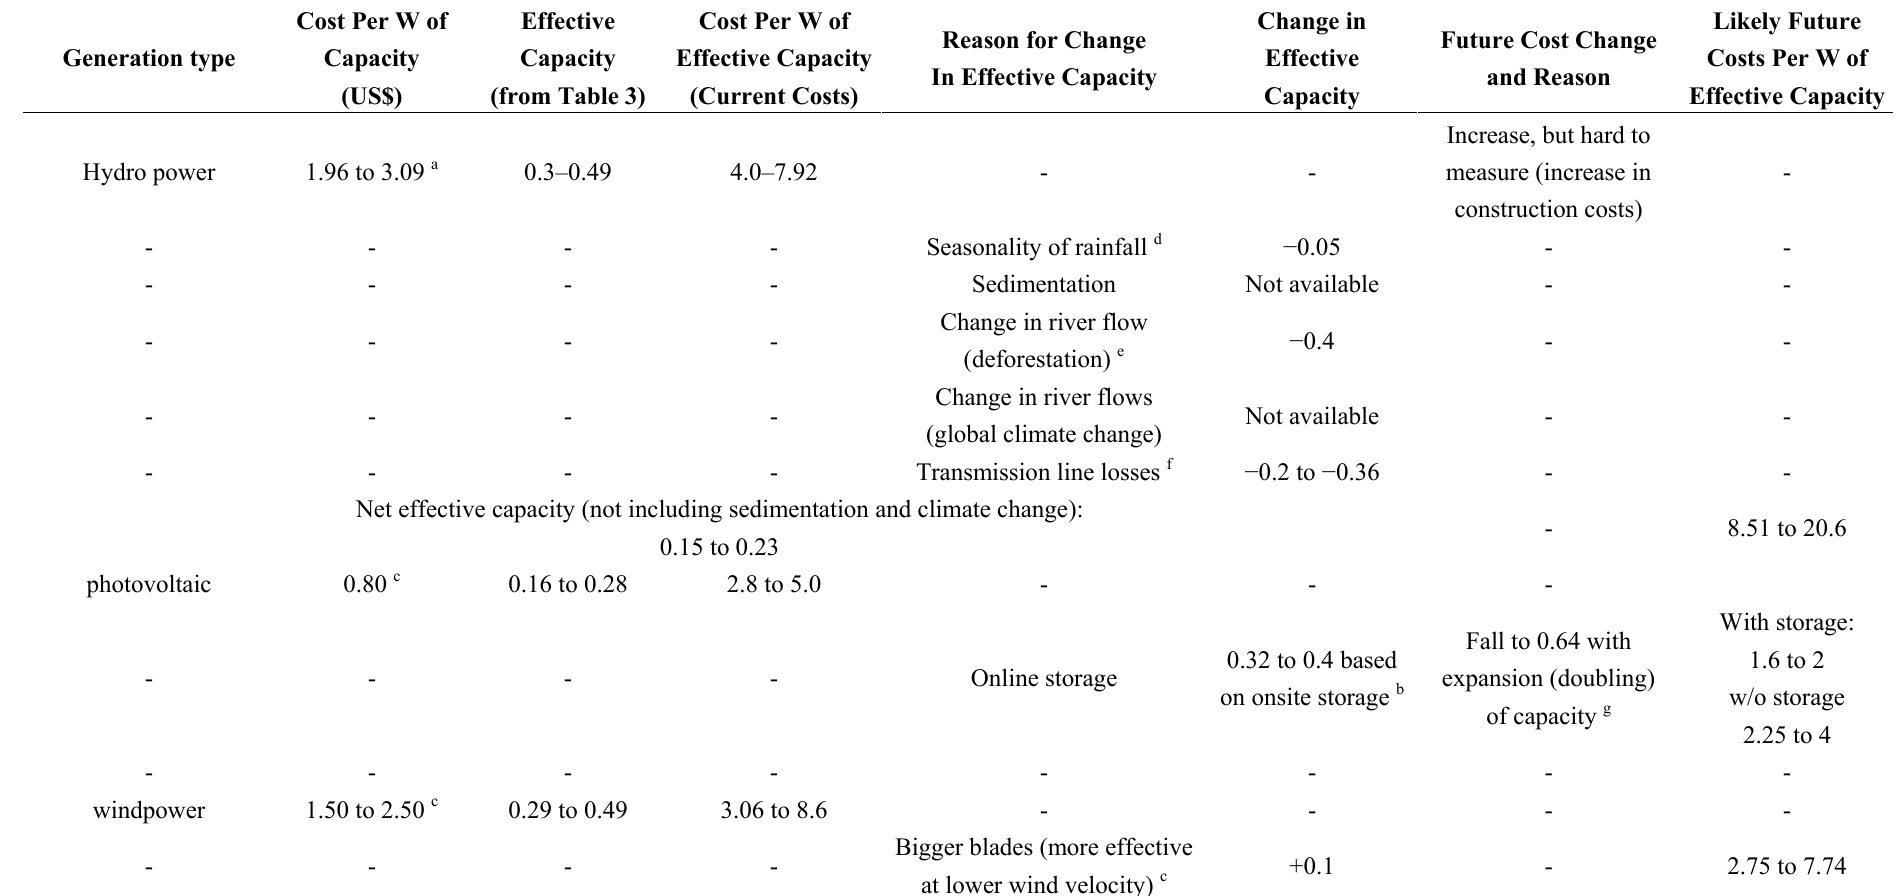
Table 4. Current and expected future cost per W of effective